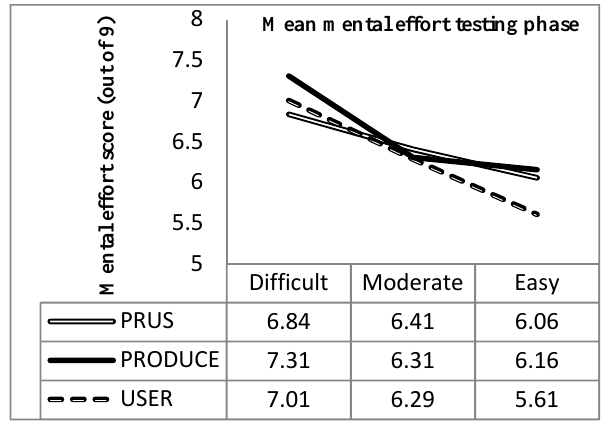
Figure 4. Group comparison of mean mental effort during testing phase.